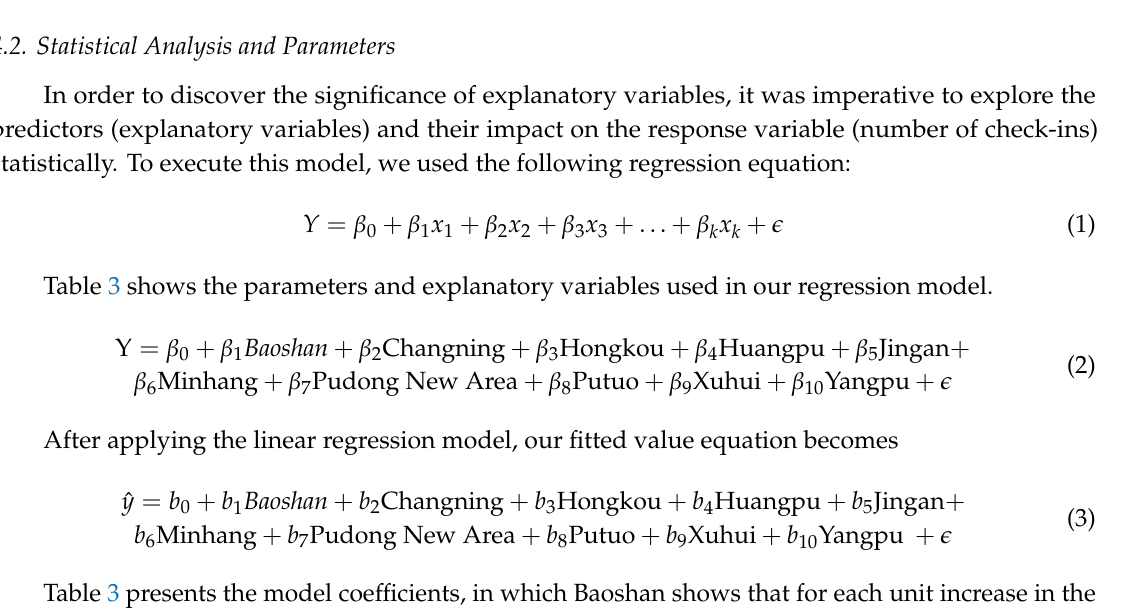
Table 3. Final multiple linear regression model interpretation.